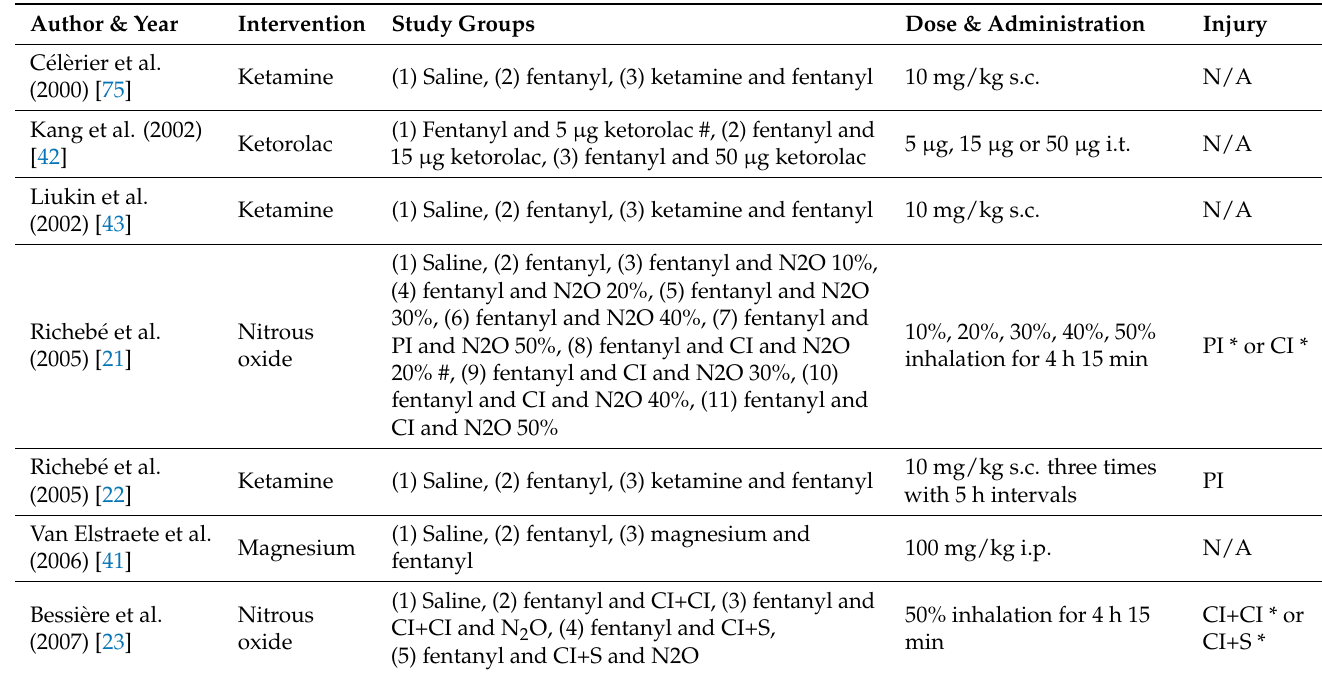
Table 2. Main characteristics of fentanyl trials. Intervention, study groups, intervention dose, administration method, and injury model used in 14 trials. #: experimental group was not statistically different from the opioid-only group. s.c.: subcutaneous. i.t.: intrathecal. i.p.: intraperitoneal. PI: plantar incision. CI: carrageenan injection. S: non-nociceptive environmental stress. N/A: